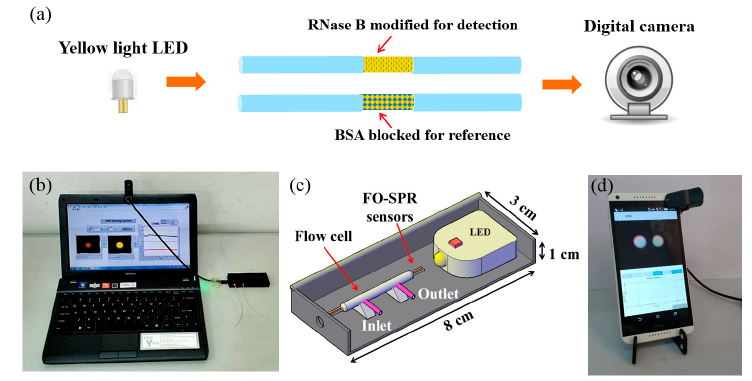
Figure 1. Dual-channel fiber optic SPR system. ( a ) Schematic of the sensor system, ( b ) Laptop-based application, ( c ) Diagram of components inside the sensing box, ( d ) Smartphone-based application.